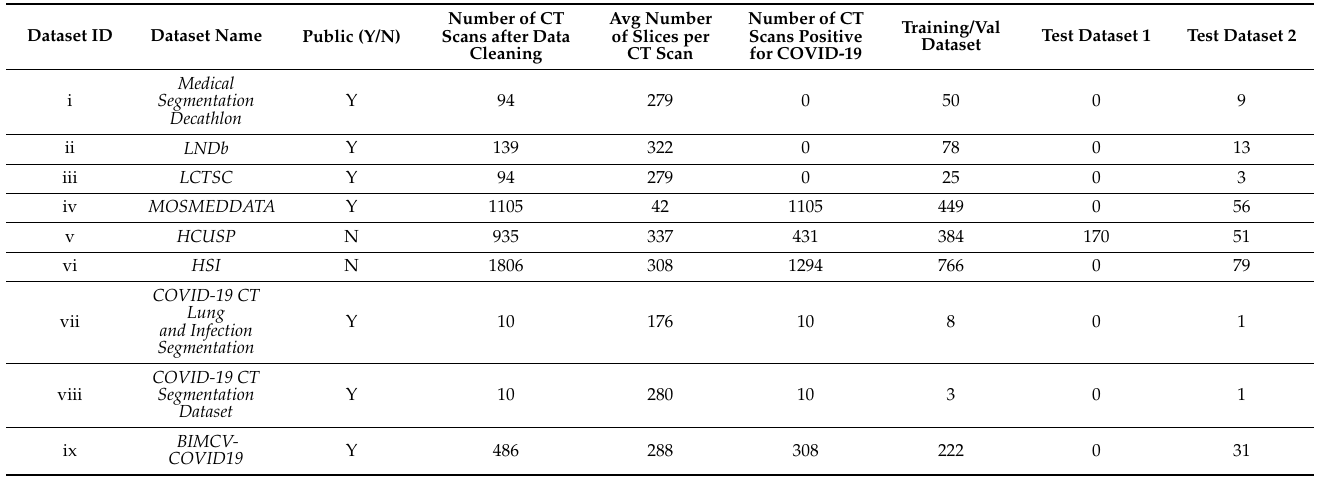
Table 2. CT scans databases used in this